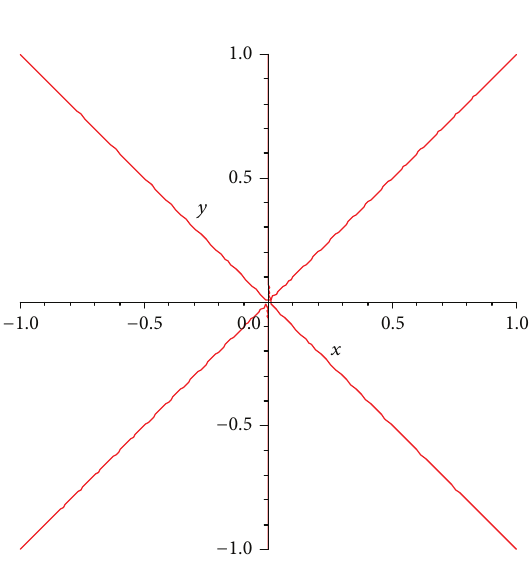
Figure 7: Rhamphoid cusp.